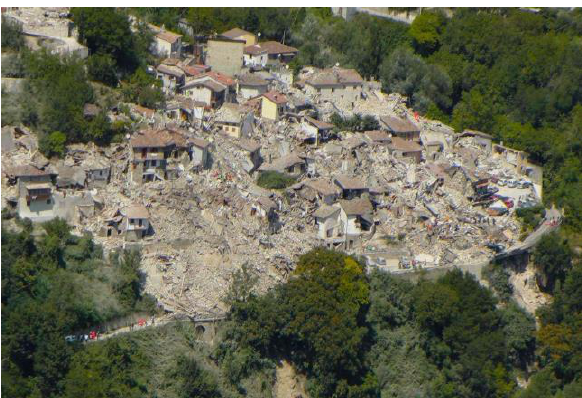
Figure 2. Accumoli (Ascoli Piceno) after 2016 earthquake.